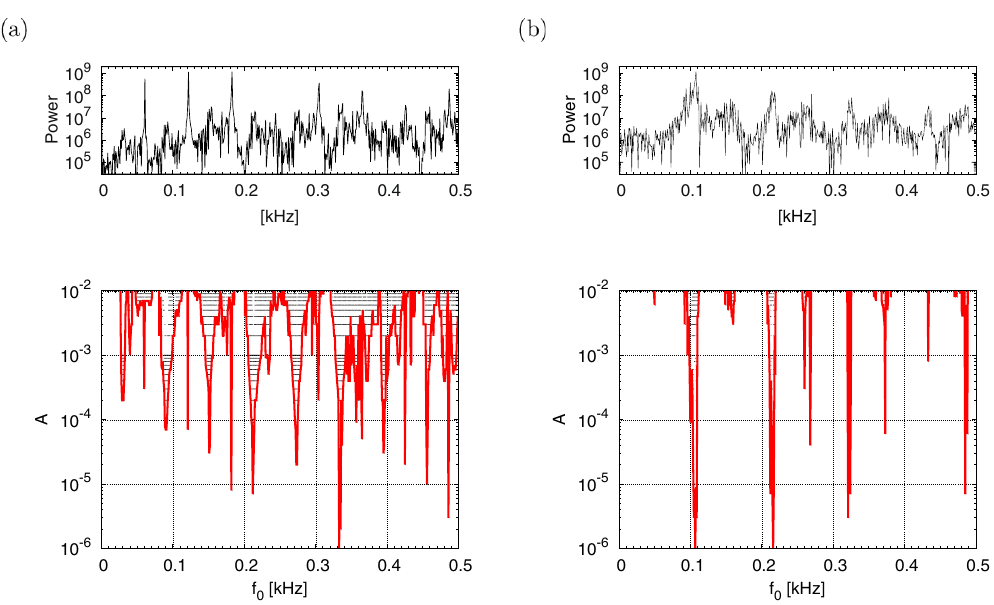
Figure 5. Power spectrum of the time series of v ( t ) in the signal-free condition (upper). Resonant frequency f 0 / amplitude A zone and points (max τ C ( τ ) > 0.5), indicated by the red line and black points, respectively, in the signal-adapted condition (lower). The resonant zones have a tendency to distribute near the peaks for the power spectrum in the signal-free condition. ( a ) Edge of the chaotic state in region #1 ( d = 0.896). ( b ) Edge of the chaotic state in region #2 ( d = −